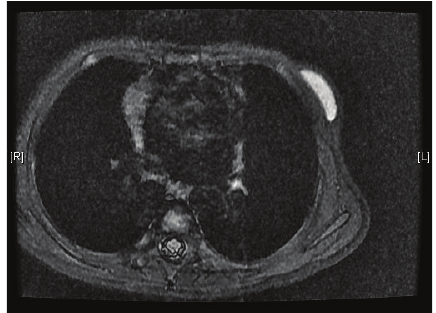
Figure 3: Magnetic resonance imaging showing a T1 hypertense lesion in left breast.